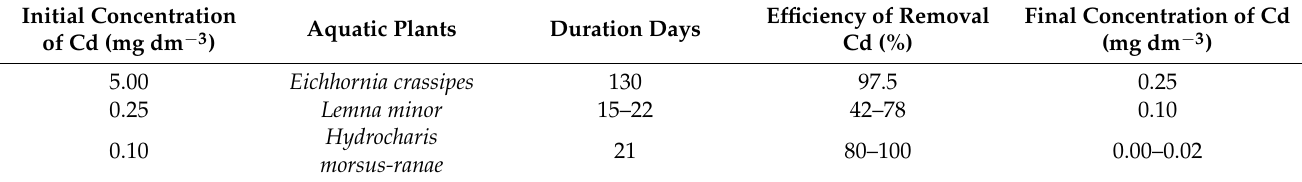
Table 15. Cadmium removal in sequential biosorption stations of various pleusophyte